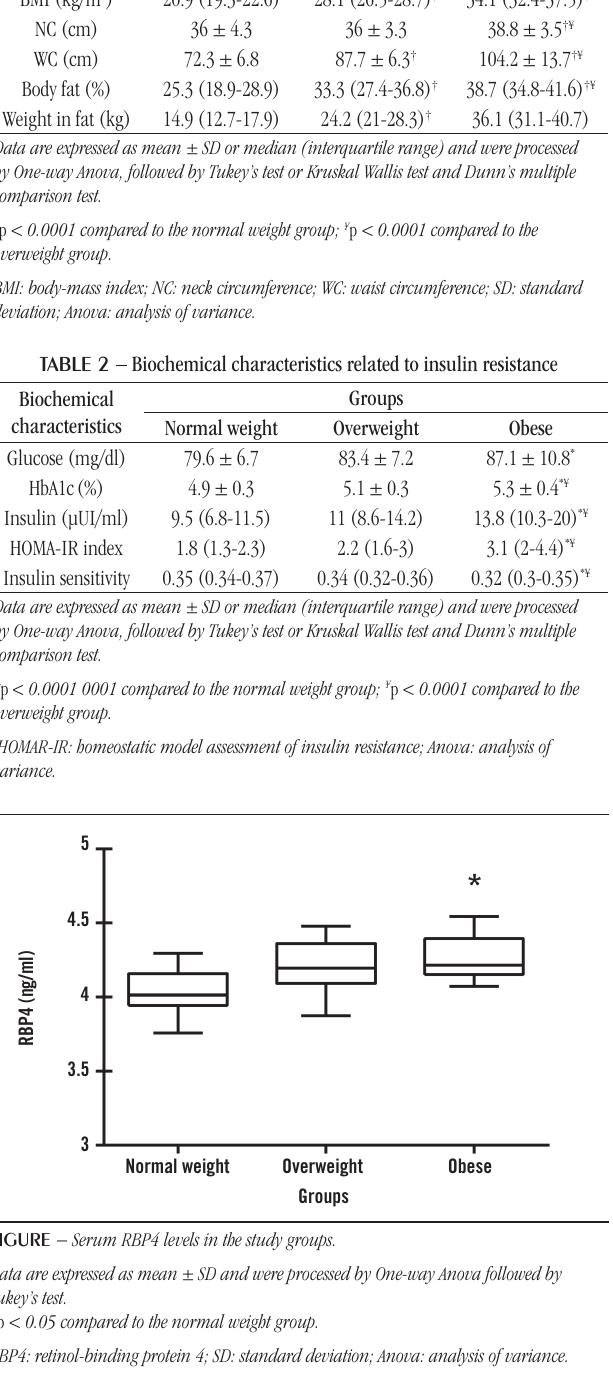
taBLE 1 − Baseline characteristics of study participants Analyzed characteristics